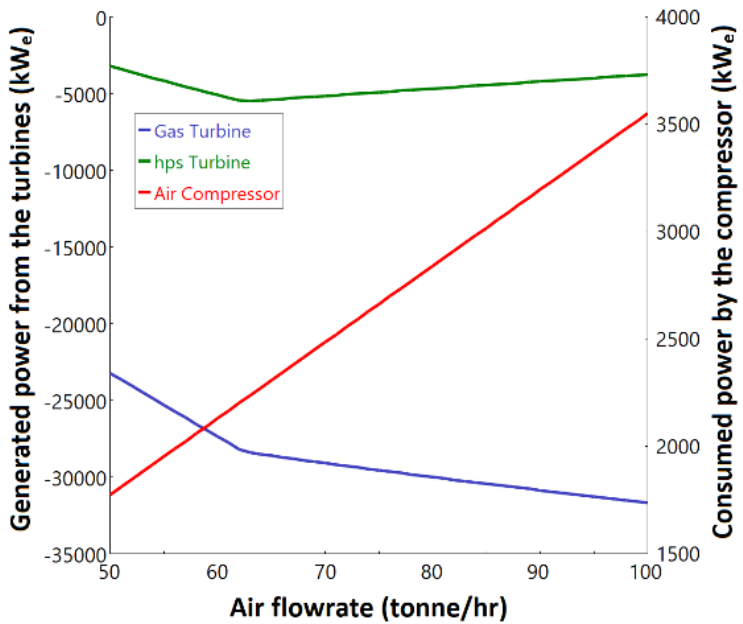
Figure 7. Effect of air flow rate on generated and consumed power in the process.